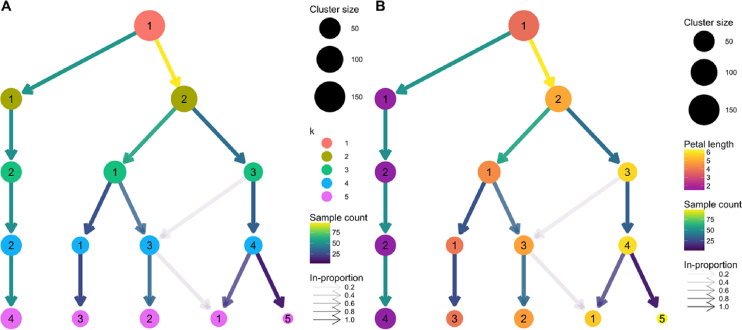
Clustering trees based on \documentclass[12pt]{minimal}
\usepackage{amsmath}
\usepackage{wasysym}
\usepackage{amsfonts}
\usepackage{amssymb}
\usepackage{amsbsy}
\usepackage{upgreek}
\usepackage{mathrsfs}
\setlength{\oddsidemargin}{-69pt}
\begin{document}
}{}$k$\end{document}-means clustering of the iris dataset. (A) Nodes are colored according to the value of \documentclass[12pt]{minimal}
\usepackage{amsmath}
\usepackage{wasysym}
\usepackage{amsfonts}
\usepackage{amssymb}
\usepackage{amsbsy}
\usepackage{upgreek}
\usepackage{mathrsfs}
\setlength{\oddsidemargin}{-69pt}
\begin{document}
}{}$k$\end{document} and sized according to the number of samples they represent. Edges are colored according to the number of samples (from blue representing few to yellow representing many). The transparency is adjusted according to the in-proportion, with stronger lines showing edges that are more important to the higher-resolution cluster. Cluster labels are randomly assigned by the \documentclass[12pt]{minimal}
\usepackage{amsmath}
\usepackage{wasysym}
\usepackage{amsfonts}
\usepackage{amssymb}
\usepackage{amsbsy}
\usepackage{upgreek}
\usepackage{mathrsfs}
\setlength{\oddsidemargin}{-69pt}
\begin{document}
}{}$k$\end{document}-means algorithm. (B) The same tree with the node coloring changed to show the mean petal length of the samples in each cluster.